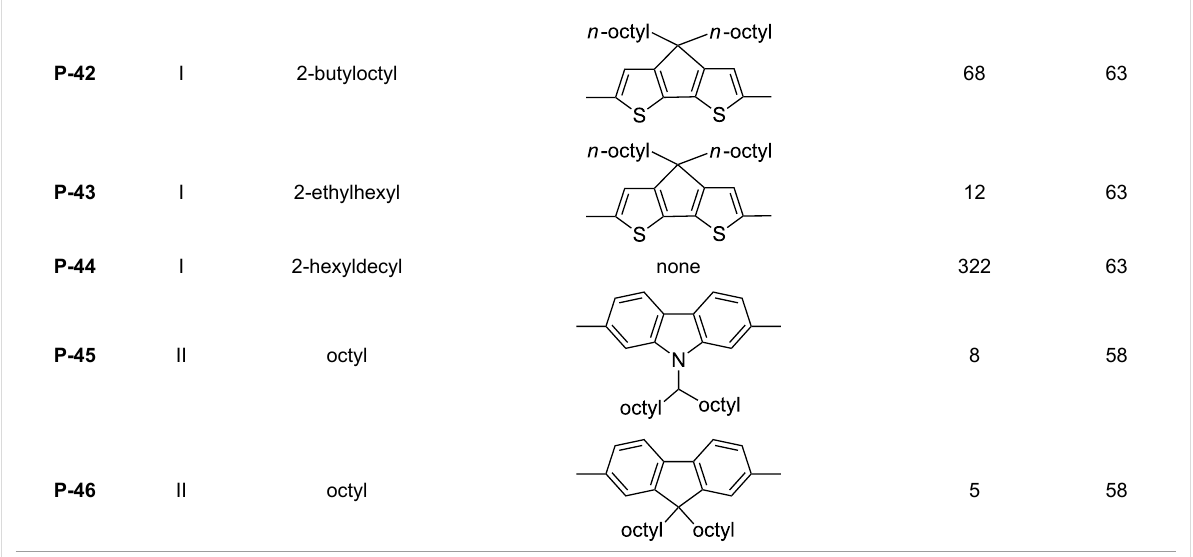
Table 5: Structure of thienyl-substituted DPP polymers used in photovoltaic devices. (continued)